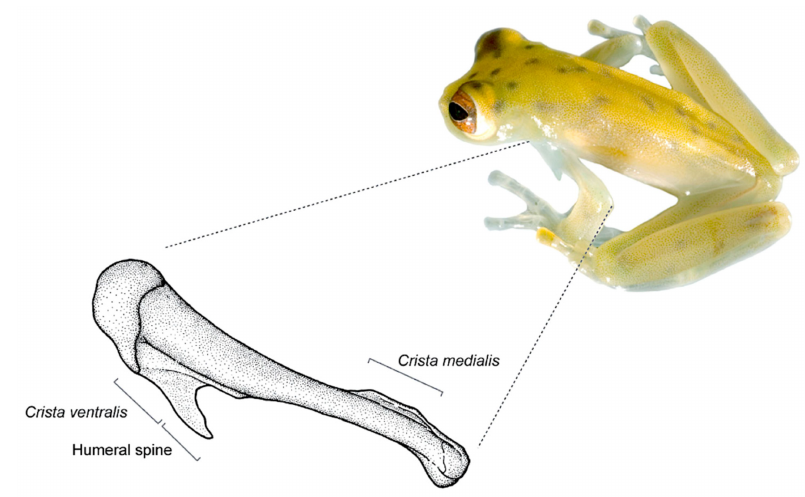
Figure 7. Humeral spine in Cochranella litoralis . Note that the humeral spine is formed by the prolongation of the crista ventralis . Photo by Luis A. Coloma; drawing by Linda Trueb.